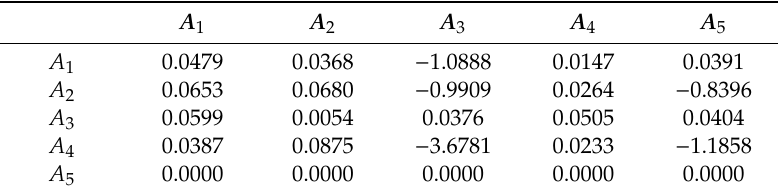
Table 19. Relative prospect dominance ϕ 5 .